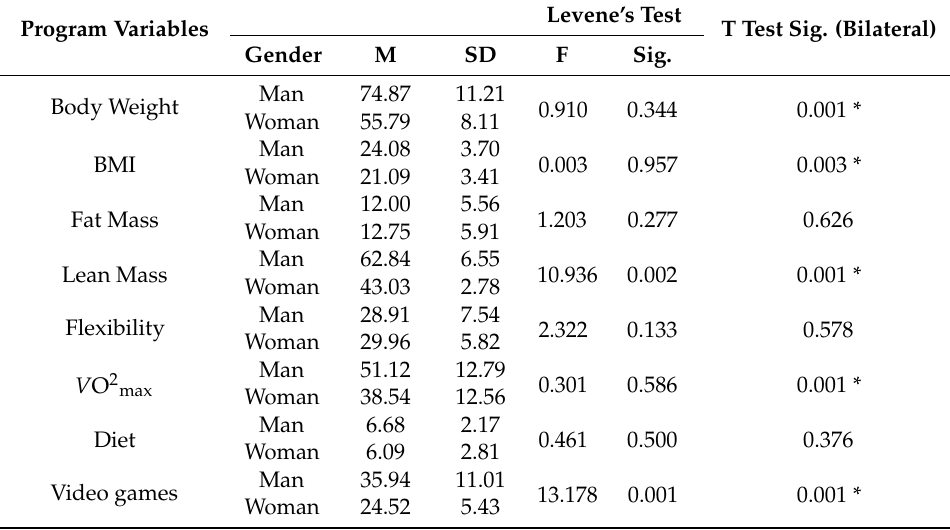
Table 1. Characteristics of the sample regarding gender prior to intervention. Program Variables Gender M SD F Sig. Man 74.87 11.21 Body Weight